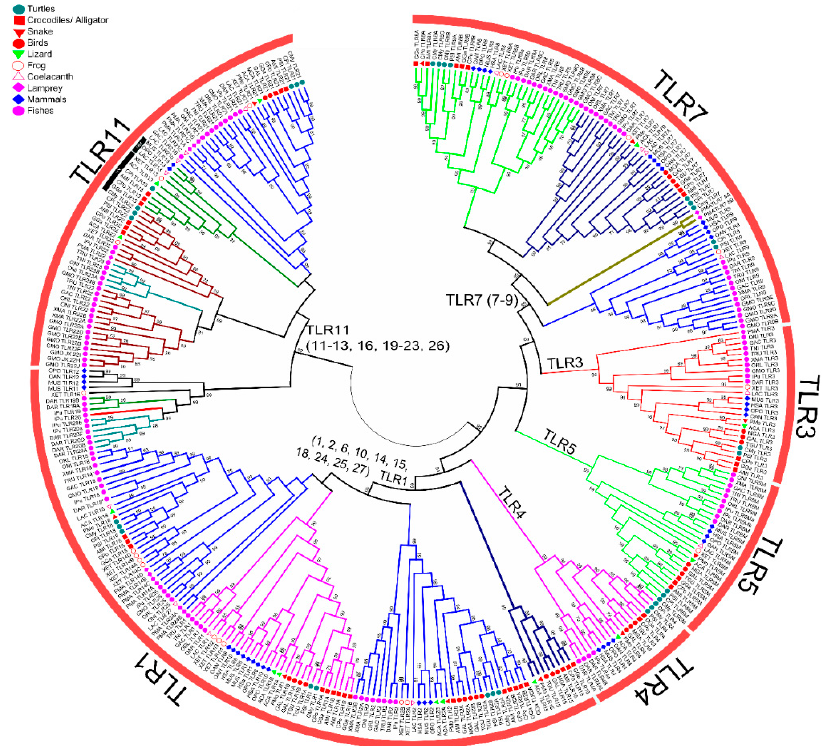
Figure 1. Phylogeny of vertebrate TLR supergene family from representative species (see Table 1). The NJ tree was made in MEGA5 with 1000 bootstrap replication.